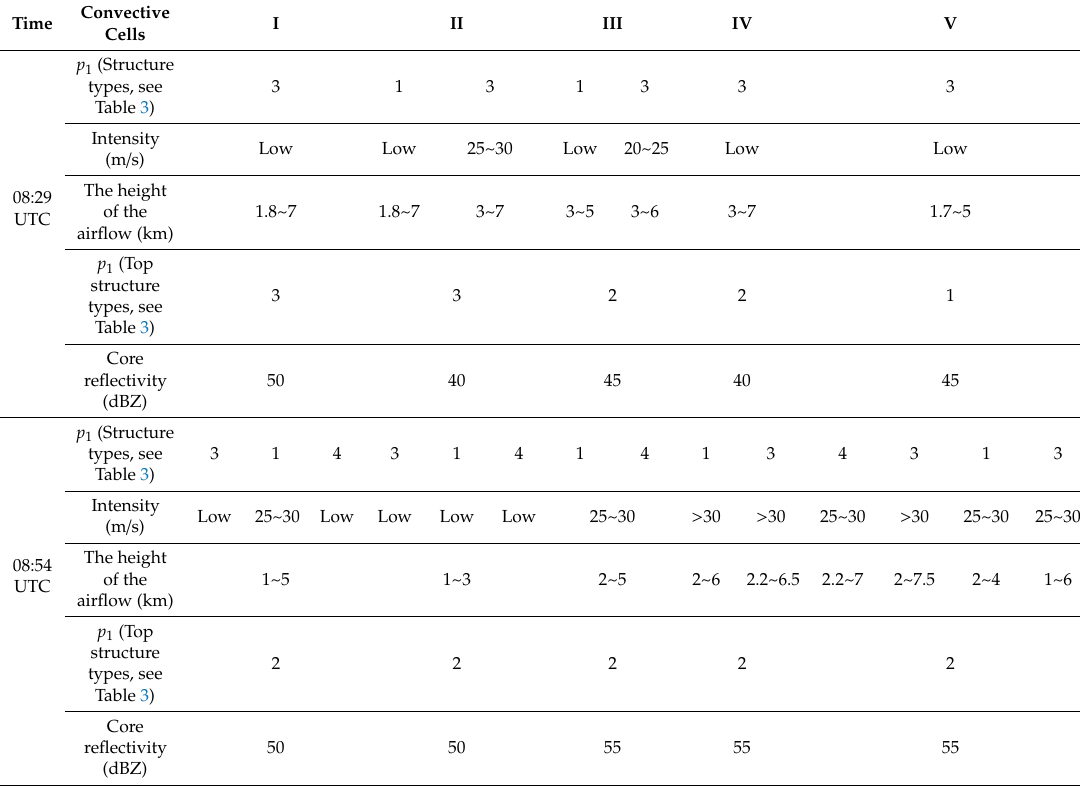
Table 4. Five micro convective cells of the squall line (13 June